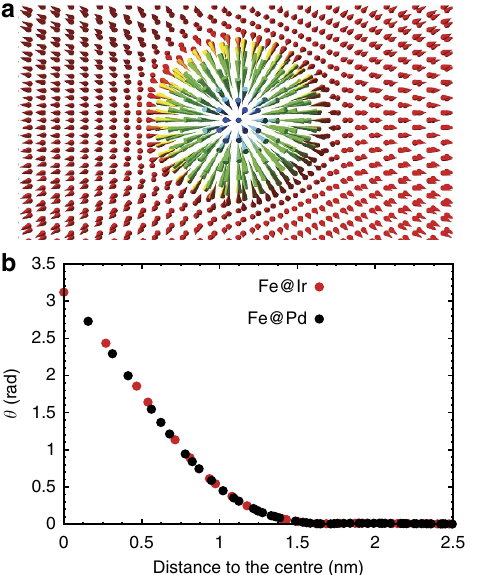
Figure 3 | Skyrmion profile in the multilayer Rh/Pd/2Fe/2Ir. ( a ) Top view of the magnetization of the skyrmion with red arrows pointing up and green/blue arrows pointing down. ( b ) Magnetization profile of an isolated skyrmion at a magnetic field of B ¼ 3.5Taveraged at a given radial distance r from the centre. The polar angle y of the magnetization vector is shown as a function of r . Red dots correspond to the Fe atoms at the Fe/Ir interface and the black dots correspond to the Fe atoms on the Pd side.